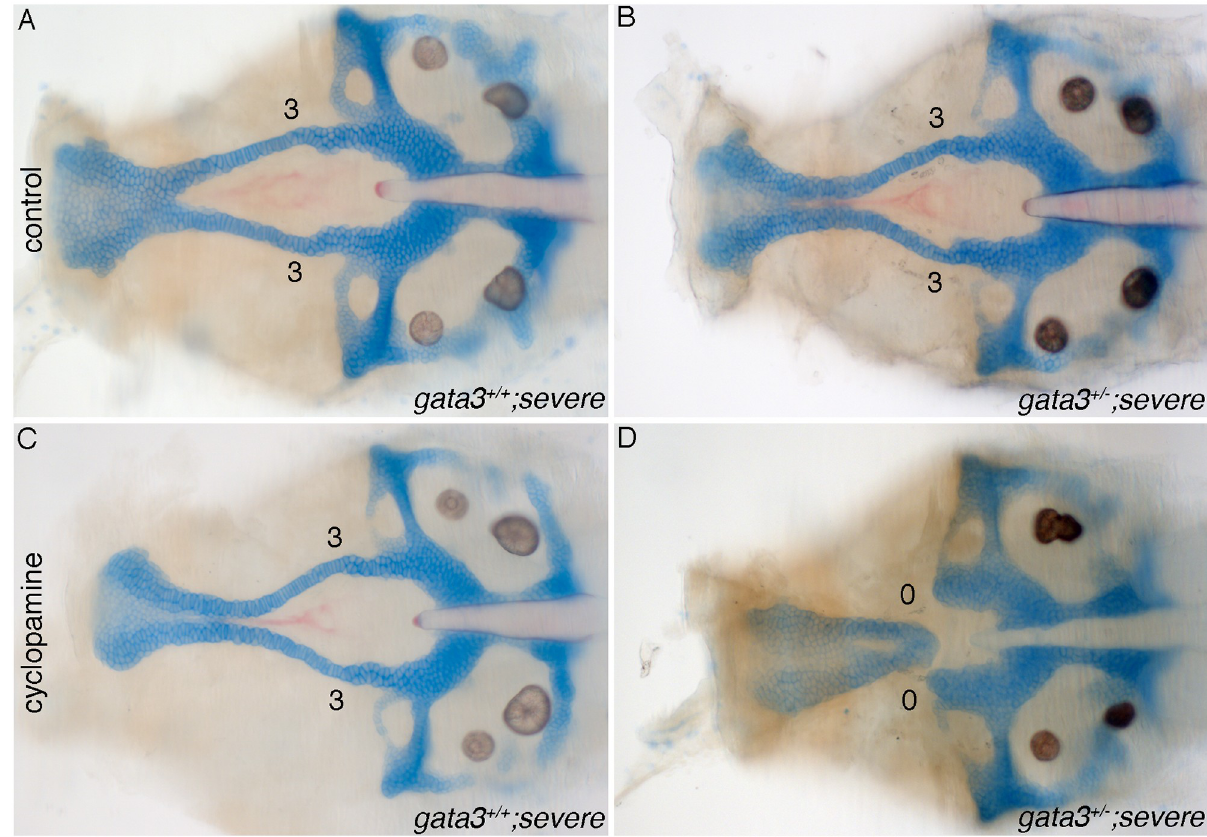
Fig 9. Reduction of Shh signaling can induce gata3 haploinsufficiency. (A-D) Flat mounts of 5dpf gata3 b1075/b1075 neurocrania anterior to the left. (A-B) control untreated-embryos from the gata3 “severe” background showing normal stacking and fusion of trabeculae. Both of (A) wild type and (B) heterozygotes develop normally. (C-D) Cyclopamine-treated embryos. (C) Wild type embryo showing normal stacking and fusion of trabeculae (n = 22/22). (D) Heterozygote embryo displaying complete loss of trabeculae with severe clefts (n = 6/61).